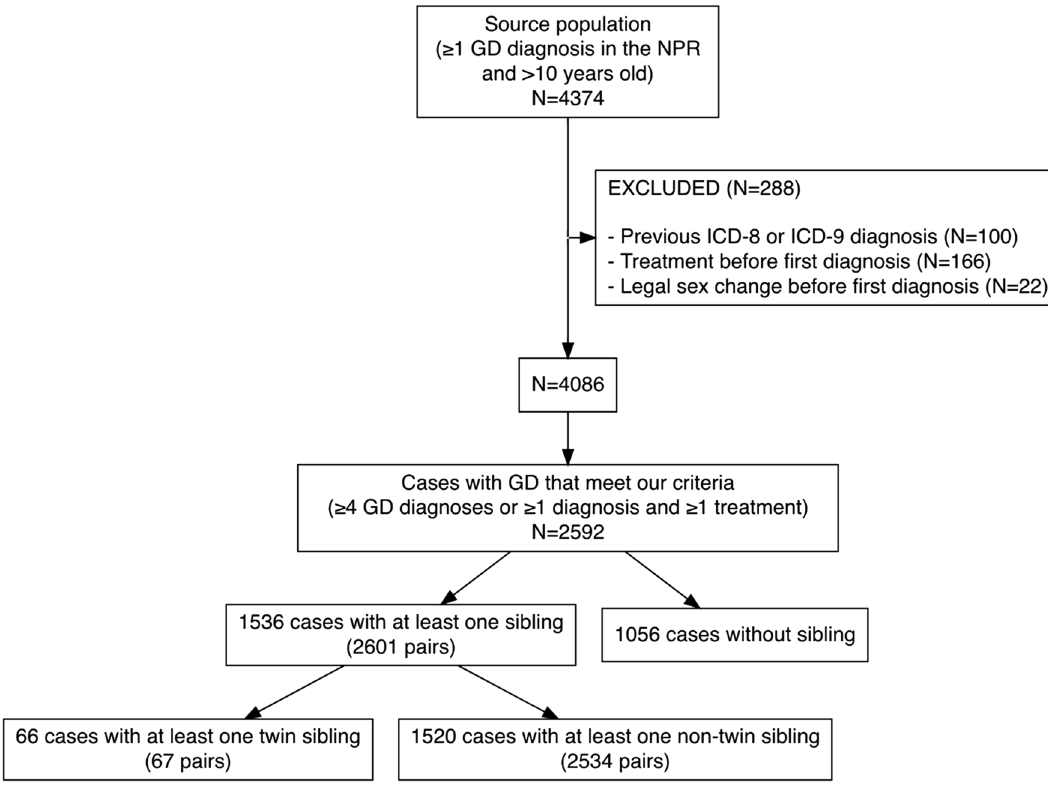
Figure 1. Flow chart of study population